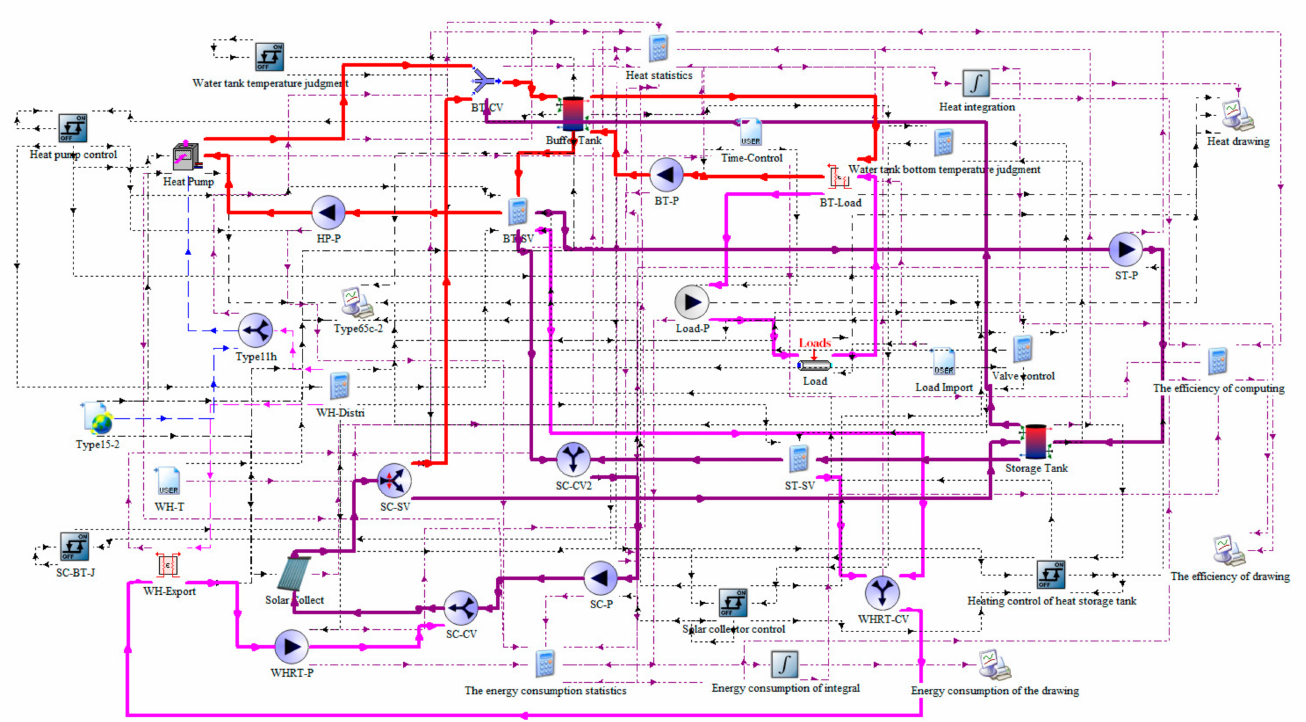
Figure 3. TRNSYS model of